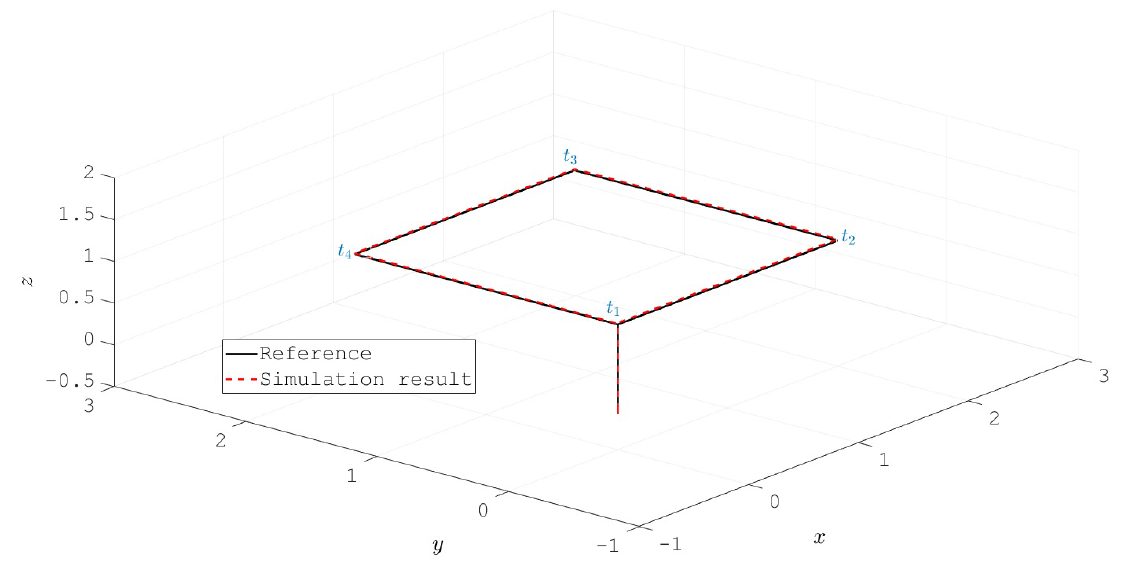
Figure 10. Position of the vehicle resulting from the attitude and altitude reference tracking.